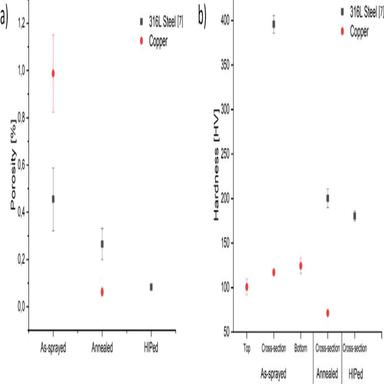
Results of a) porosity analysis and b) microhardness obtained through Vickers micro-indentation test.